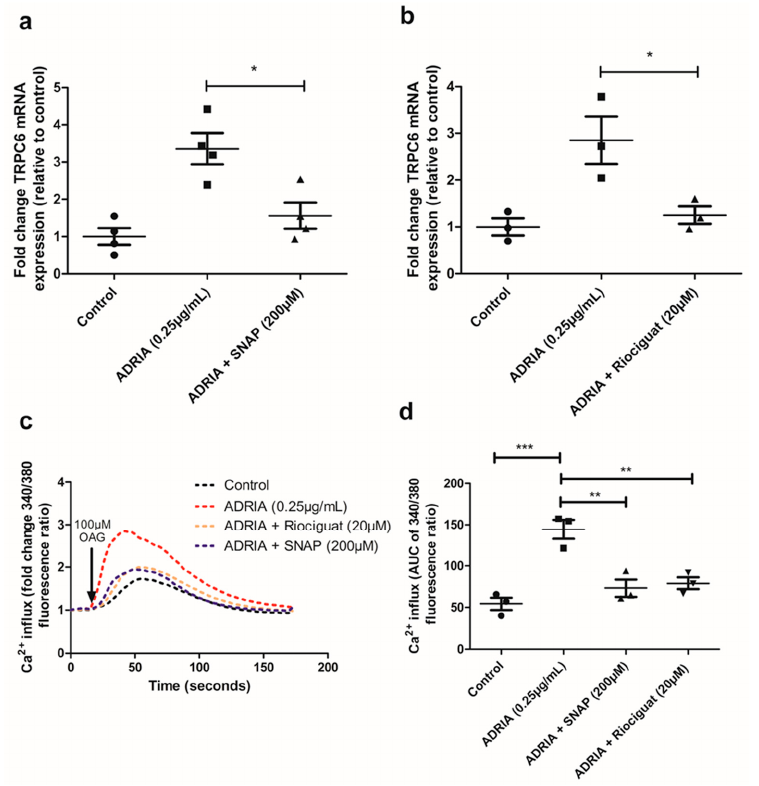
Figure 3. Riociguat and SNAP prevent Adriamycin-induced TRPC6 overexpression and activity in podocytes. hPOD were treated for 24 h with 0.25 µg/mL Adriamycin to induce podocyte injury. Podocytes were simultaneously treated with either 20 µM Riociguat or 200 µM SNAP. ( a , b ) RNA was isolated and TRPC6 mRNA expression was determined or ( c ) intracellular Ca 2+ dynamics were determined using Fura-2 ratiometry upon stimulation with 100 µM OAG. ( d ) Area under the curve of the fold change in the 340/380 ratio of Fura-2 AM was calculated to quantify Ca 2+ concentrations. * p < 0.05 ** p < 0.01 *** p < 0.001.